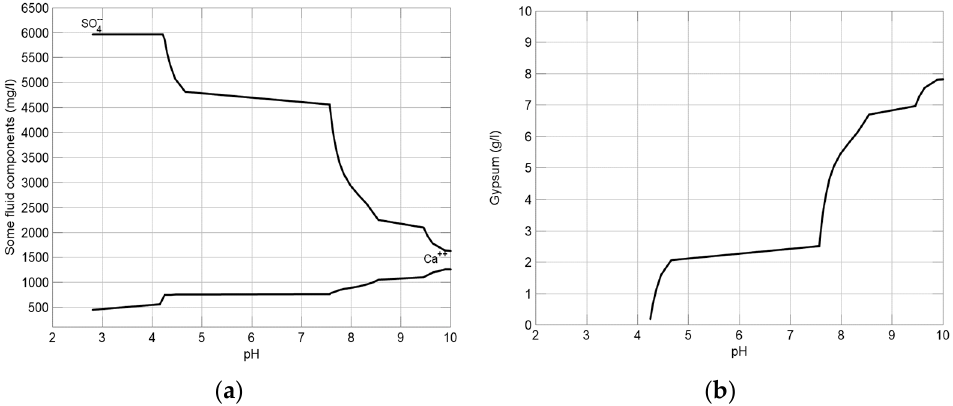
Figure 5. Simulation results for the ( a ) Ca 2+ and SO 42 − concentrations and ( b ) the amount of gypsum with an increasing pH.